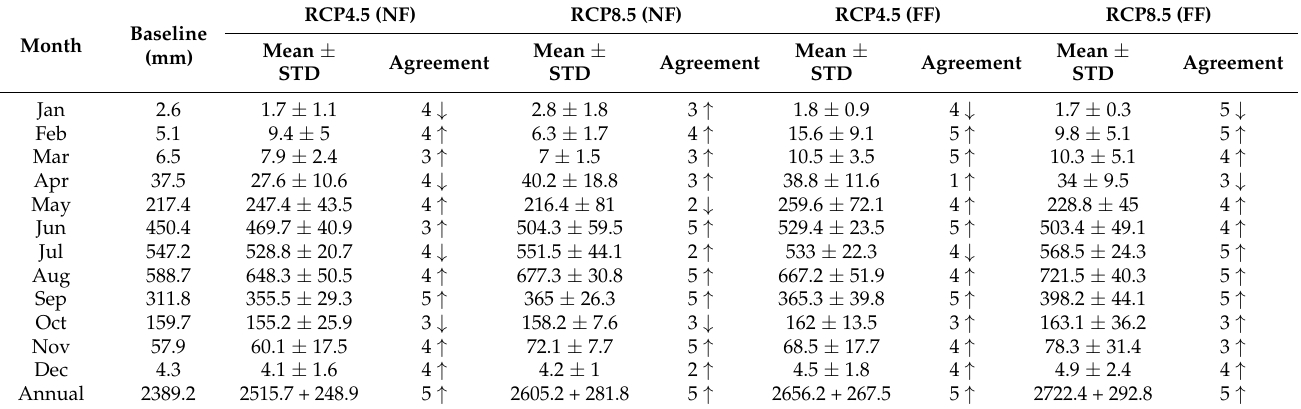
Table 5. Baseline monthly rainfall (mm) in Sittaung, the projected mean and standard deviation monthly rainfall (mm) for RCP 4.5 and RCP8.5 scenarios, and agreement among the number of GCMs in the direction of change. The arrows in agreement indicate the direction of change with up arrow indicating increase and down arrow indicating decrease from baseline values.